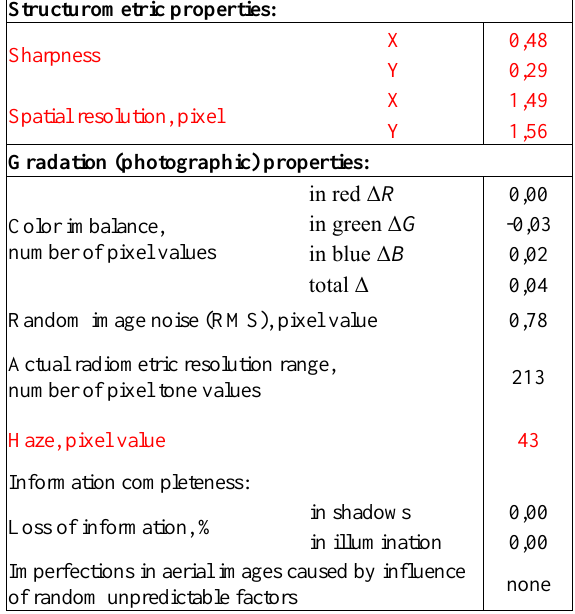
Figure 17. Aerial image, obtained by camera Sony RX, installed on light UAV and graphs of the color balance for each of the color component, the image has good visual quality Structurometric properties: